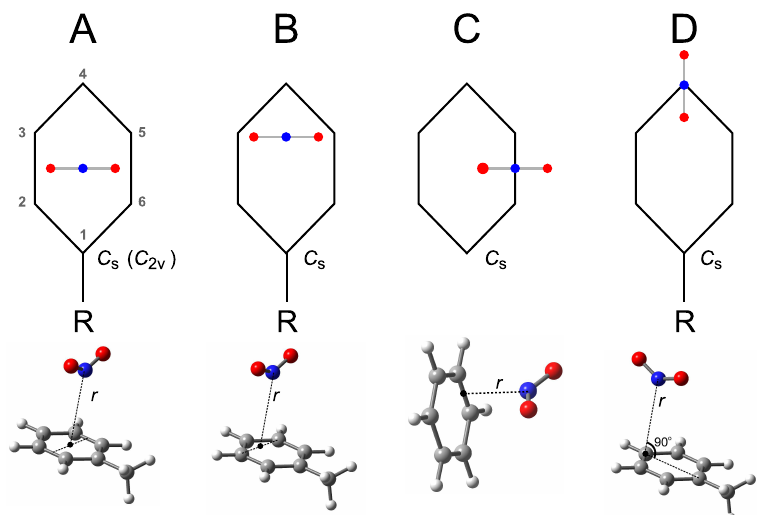
Figure 1. Illustrative pictures of the explored coordination paths. In path A, the projected direction of N–O bonds lies parallel to the line bisecting the bonds between ortho and meta C atoms of the aromatic ring, with N insisting perpendicularly over the geometric center of the ring; r denotes the distance between N and the center of the ring. Arrangement A assumes C s ( C 2v ) symmetry for toluene (benzene). In path B, the projected direction of N–O bonds lies parallel to the line connecting C3 and C5, with N insisting perpendicularly over the center of that line; r denotes the distance between N and the midpoint of the C3–C5 line. In path C, the projected direction of N–O bonds lies parallel to the line bisecting one of the C-C bonds of the aromatic ring; for 2 B 2g ( 2 B 3g ) states of benzene, the compressed (elongated) C-C bond has been chosen, with N insisting perpendicularly over the center of that bond; r denotes the distance between N and the center of the C-C bond. In path D, the projected direction of N–O bonds lies parallel to the line connecting the C bearing the R substituent and the C in para position, with N insisting perpendicularly over the carbon in para; r denotes the distance between N and the C atom in para position.